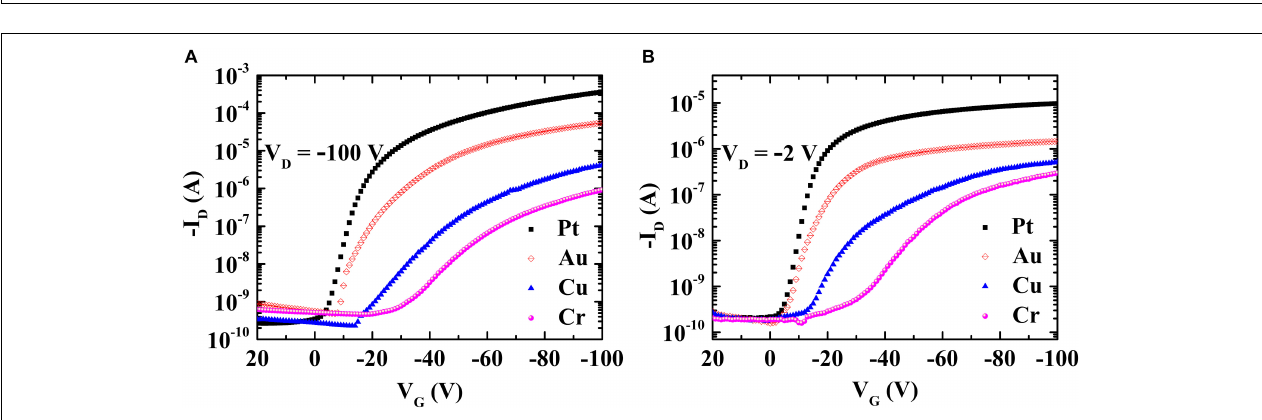
FIGURE 1 | (A) Schematic illustration of the device structure of top-gated IDT-BT OFETs. (B) Molecular structure of IDT-BT polymer.